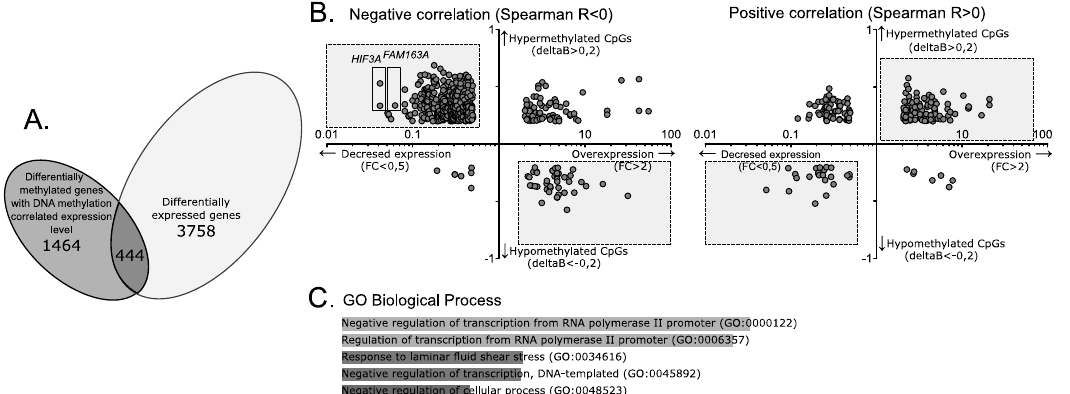
Figure 3. The role of CpG methylation in the expression of genes differentially expressed in gonadotroph NFPAs. ( A ) Overlap between genes for which expression level was correlated with aberrant CpG methylation and genes differentially expressed in gonadotroph NFPAs and normal pituitary sections. ( B ) Analysis of the direction of the DNA methylation difference and the direction of expression change of genes associated with CpGs with negative and positive methylation/expression correlations. Each dot represents a particular CpG site. The difference in the DNA methylation level, where delta β > 0 denotes hypermethylation and delta β < 0 denotes hypomethylation, is presented on the y-axis. Fold change in gene expression is presented on the x-axis. CpGs with a methylation difference and a sign of methylation/expression correlation concordant with the direction of the gene expression change are shown in gray boxes. ( C ) The top five Gene Ontology (GO) processes enriched for differentially expressed genes with expression levels correlated with methylation levels of the annotated differentially methylated CpGs.